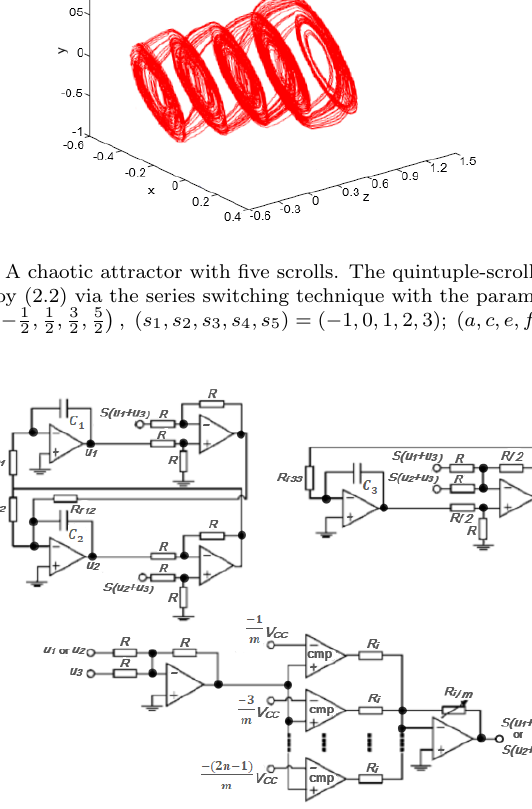
Figure 6. Circuit diagram, able to produce a chaotic attractor with seven